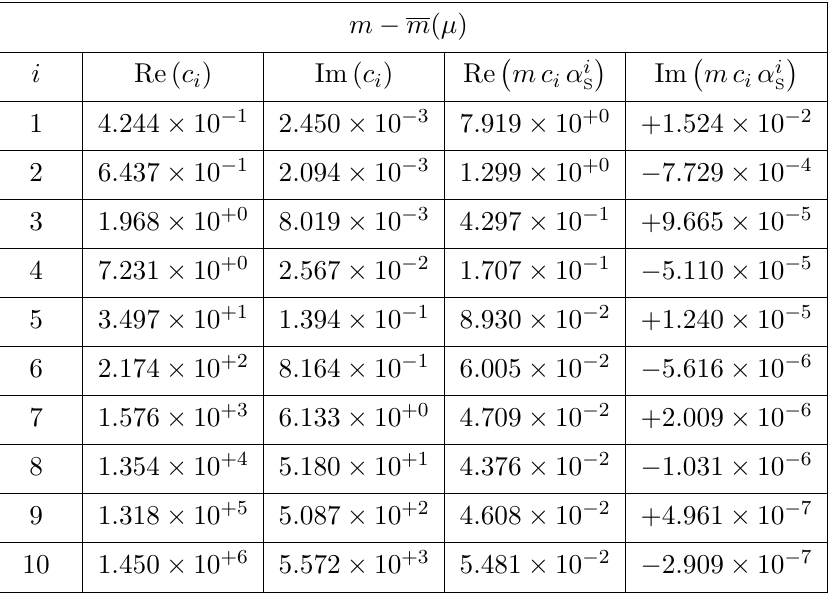
Table 2 . Real and imaginary parts of the coe(cid:14)cients c i of the mass relation (8.2), up to the tenth order in the strong coupling constant (cid:11) ( (cid:22) ), with (cid:22) 2 = Re( m 2 S